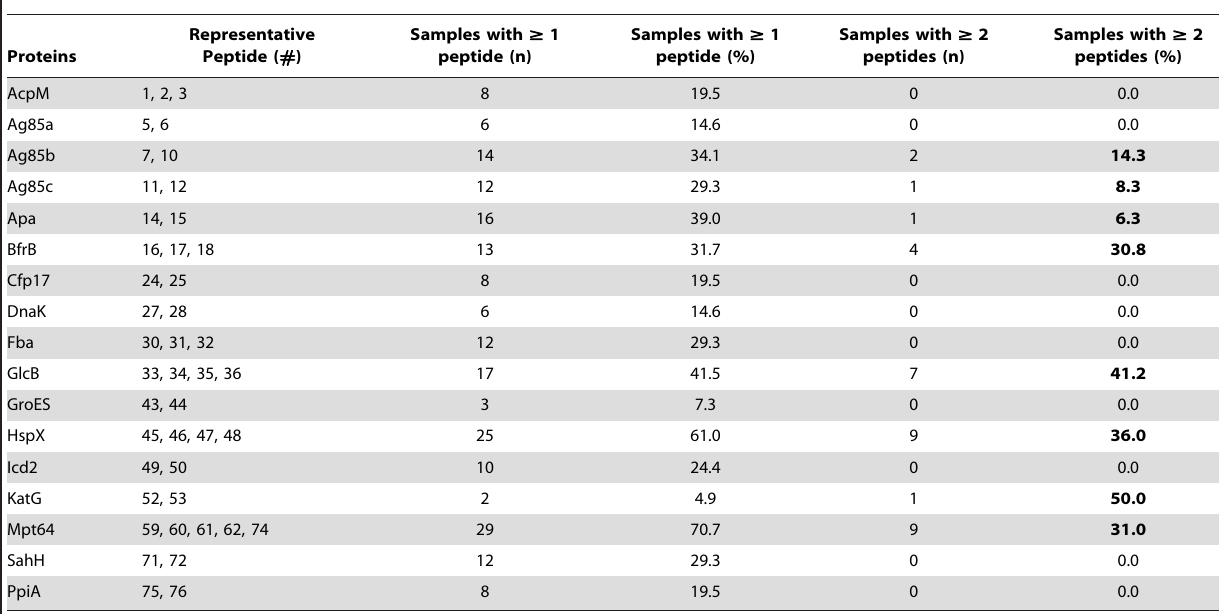
Table 4. Mycobacterial proteins identified by multiple peptides in TB patient samples.